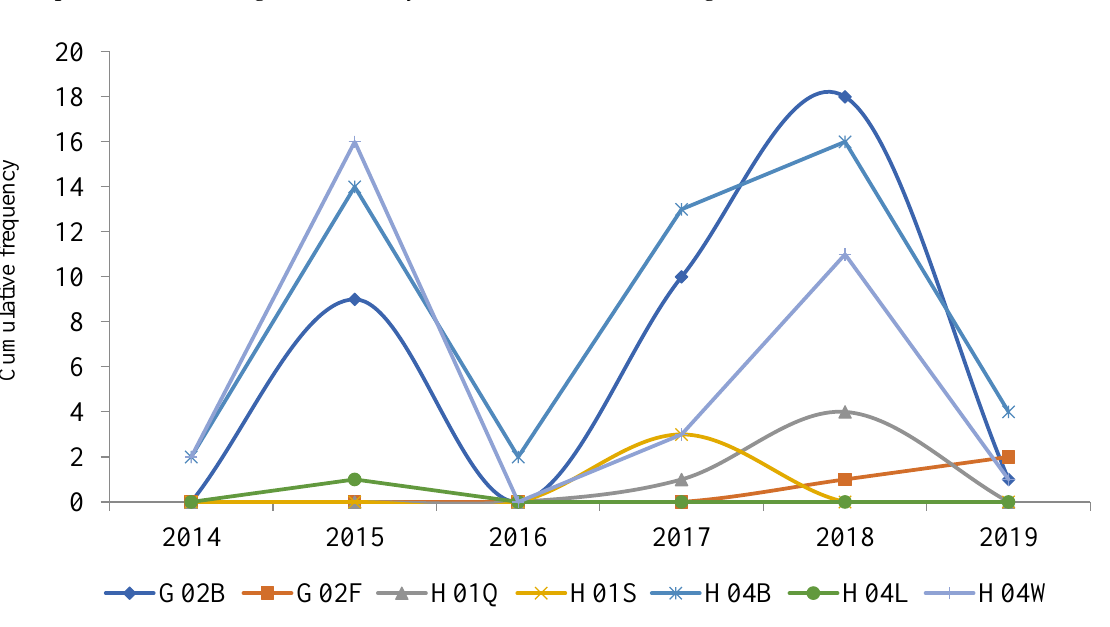
Figure 2. Changes in the key 5G photonic technologies from 2014 to 2019. Note: The 2019 statistics only contain data until April 30, 2019